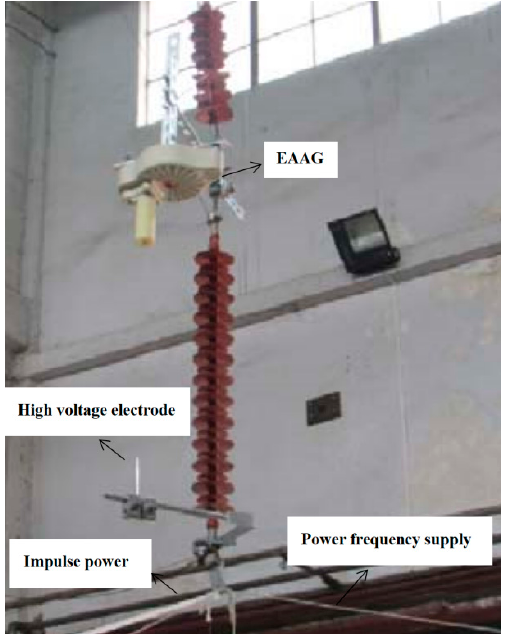
Figure 13. Diagram of the field installation of the test system.